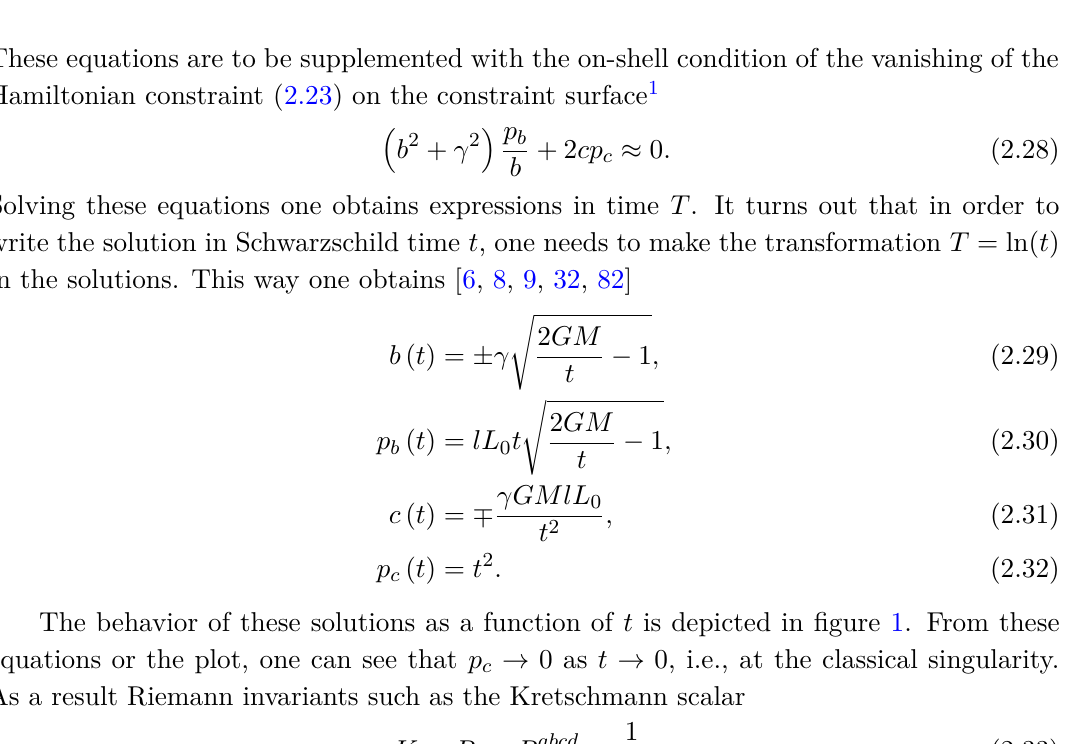
Figure 1 . The behavior of canonical variables as a function of the Schwarzschild time t . We have chosen the positive sign for b and negative sign for c . The figure is plotted using γ = 0 . 5 , M = 1 , G = 1 and L 0 = 1